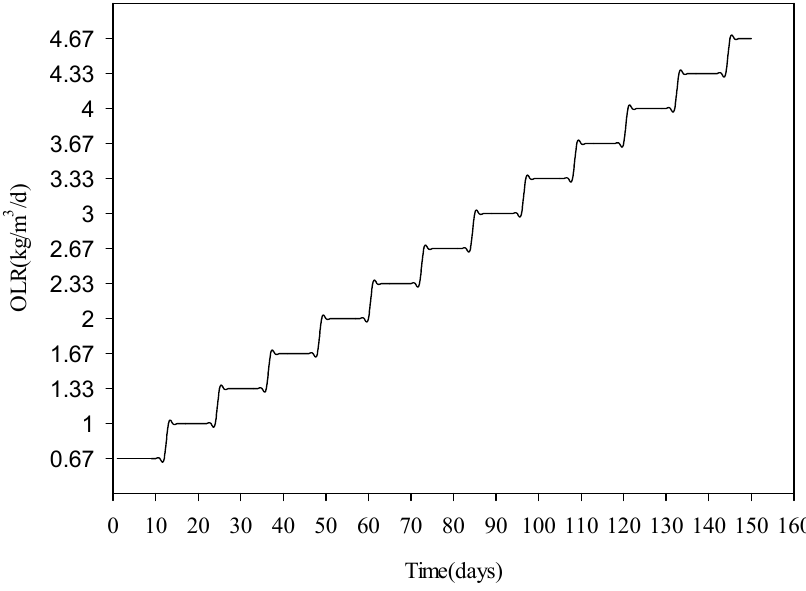
◦ C. OLR = organic loading